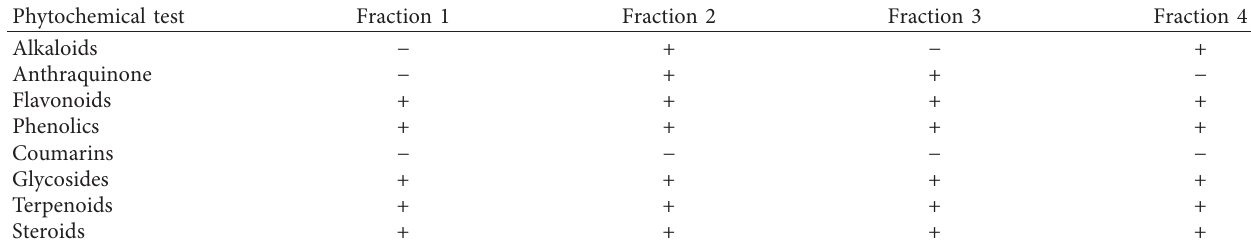
Table 2: Phytochemical screening for fractions.